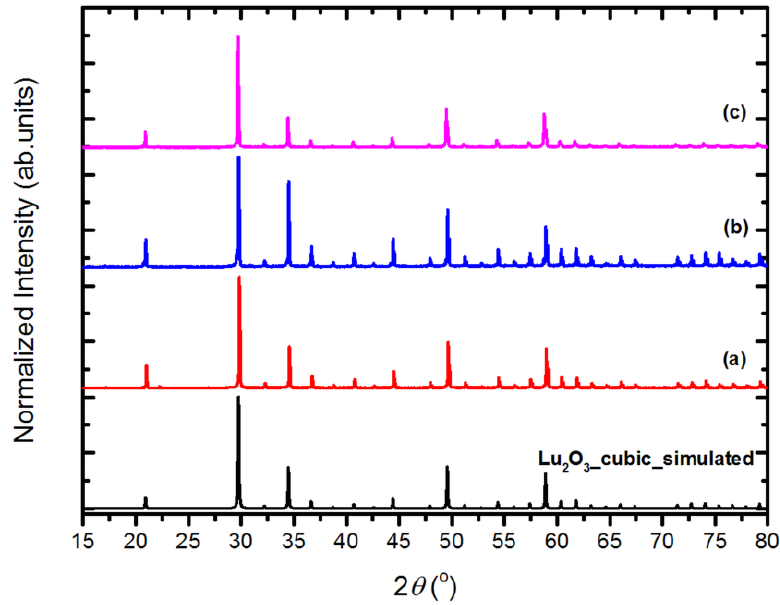
Figure 2. Representative XRD patterns of Lu 2 O 3 powders of Series II, III and IV. ( a ) SII-1; ( b ) SIII-3; ( c ) SIV-2, together with simulated pattern of a cubic Lu 2 O 3 (data from this work).